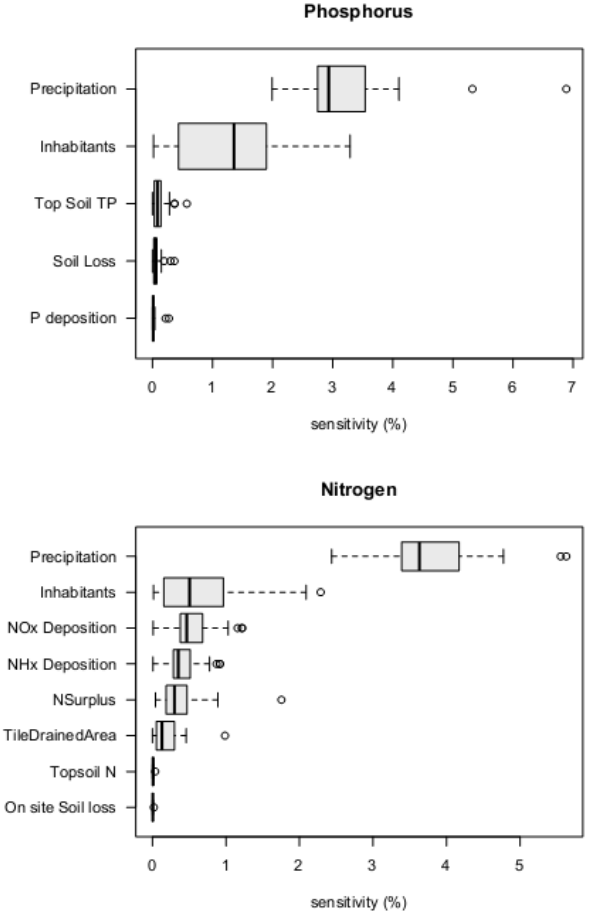
Fig. 7. Model sensitivity to input data for phosphorus and nitrogen. Input data item box plots across subcatchments summarise the sen- sitivity of the